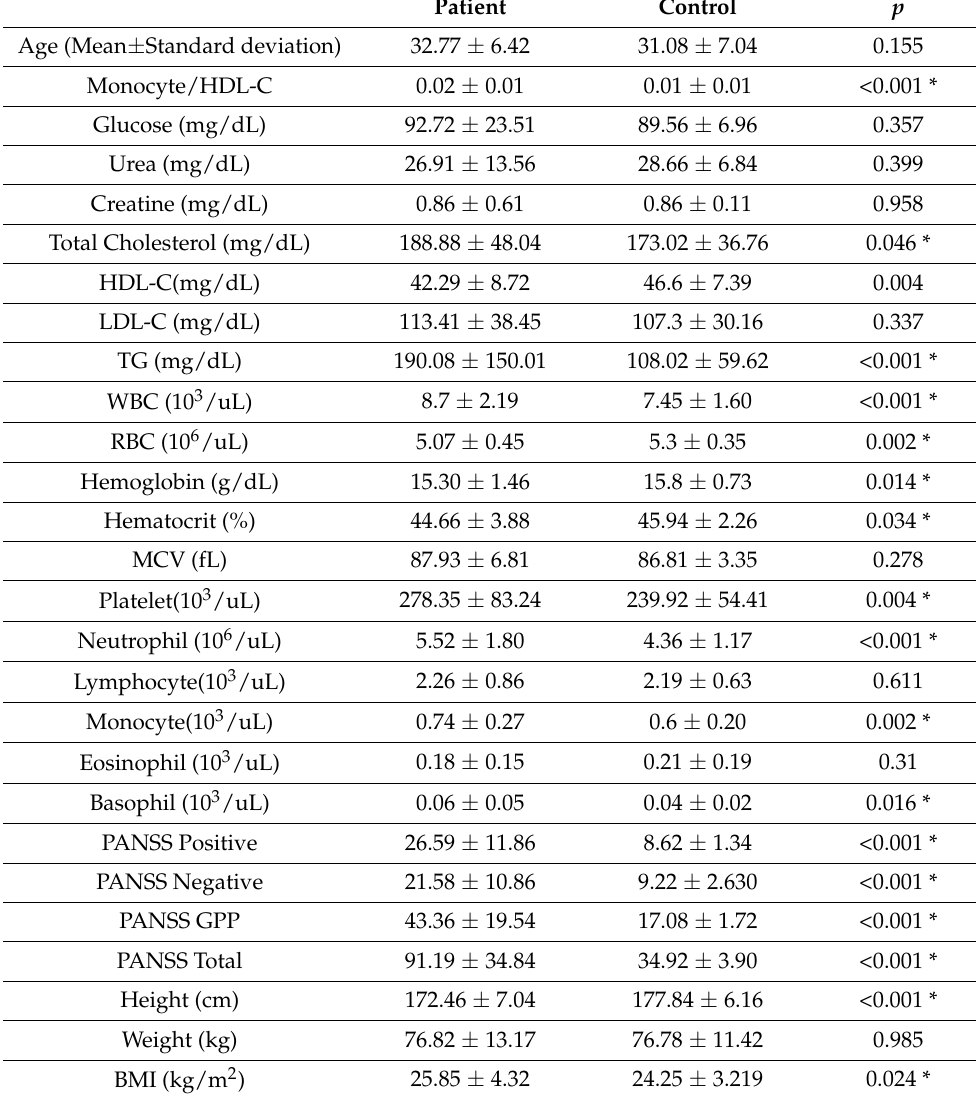
Table 2. Scale scores and laboratory parameters of the patient and control